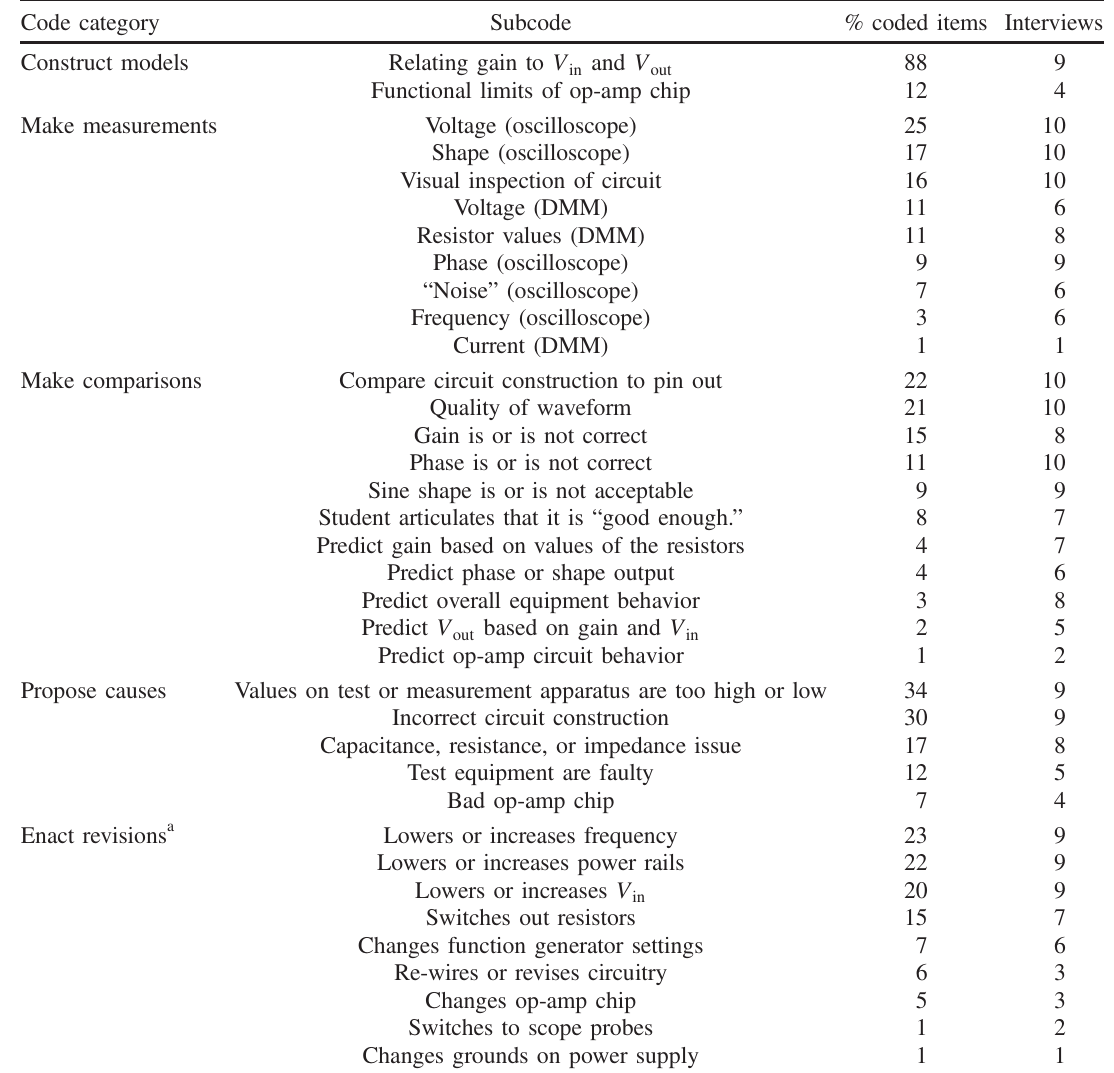
TABLE III. List of emergent subcodes from the analyzed transcripts. The percentage of coded items refers to how many times a 30-sec interval was coded with each code category (subtask). The last column denotes how many interviews out of 10 had at least one instance of the corresponding